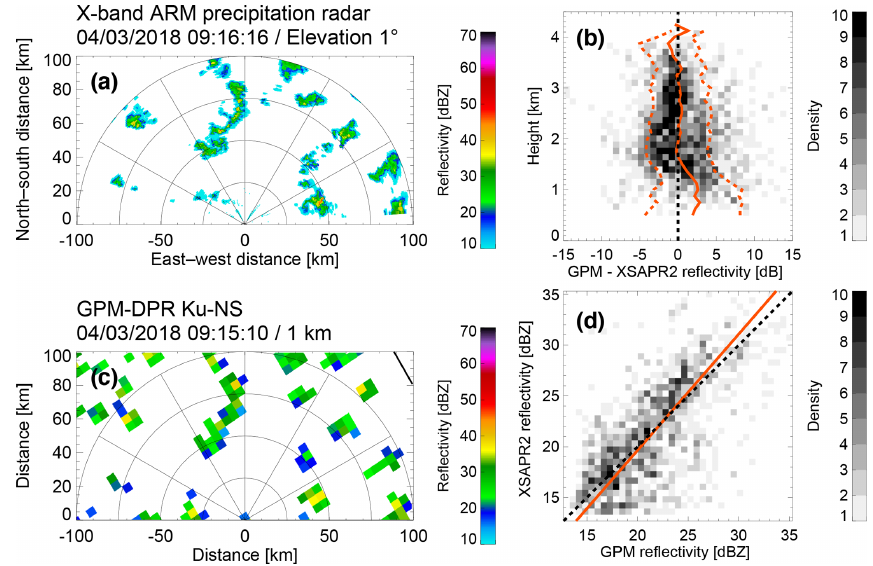
Figure 4. For the conditions that occurred on 4 March 2018 around 09:15UTC as observed by (a) XSAPR2 radar reflectivity at 1 ◦ eleva- tion and (c) GPM-DPR Ku-band radar reflectivity at 1km height. For the entire geometry-matching dataset with 1516 points used for the calibration: (b) scatter, mean (orange) and standard deviation (dashed lines) of the difference between the GPM-DPR Ku band and XSAPR2 radar reflectivity measurements as a function of height and (d) a scatterplot comparing the XSAPR2 and GPM-DPR Ku-band reflectivity measurements above the GPM surface echo height of 1.5km. Also plotted is the 1-to-1 relationship (dashed line) and the best linear fit to the observations (solid orange